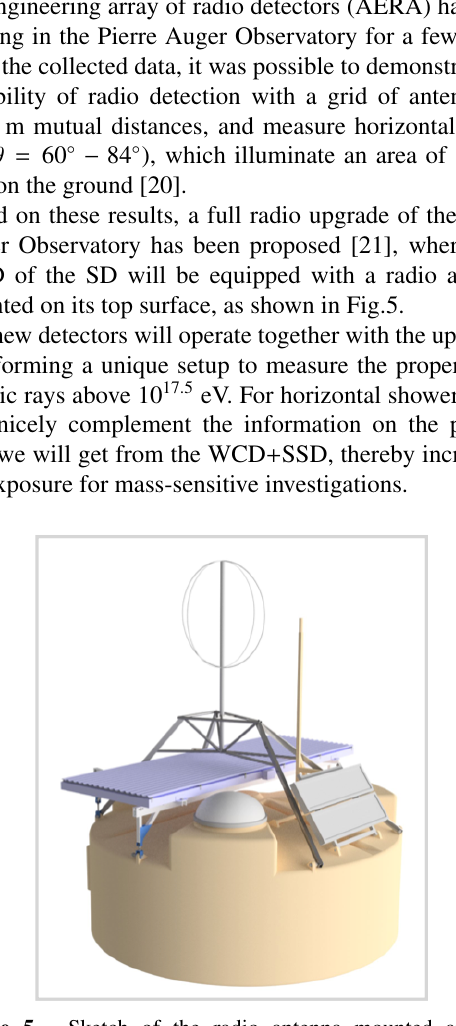
Figure 5. Sketch of the radio antenna mounted atop the WCD +